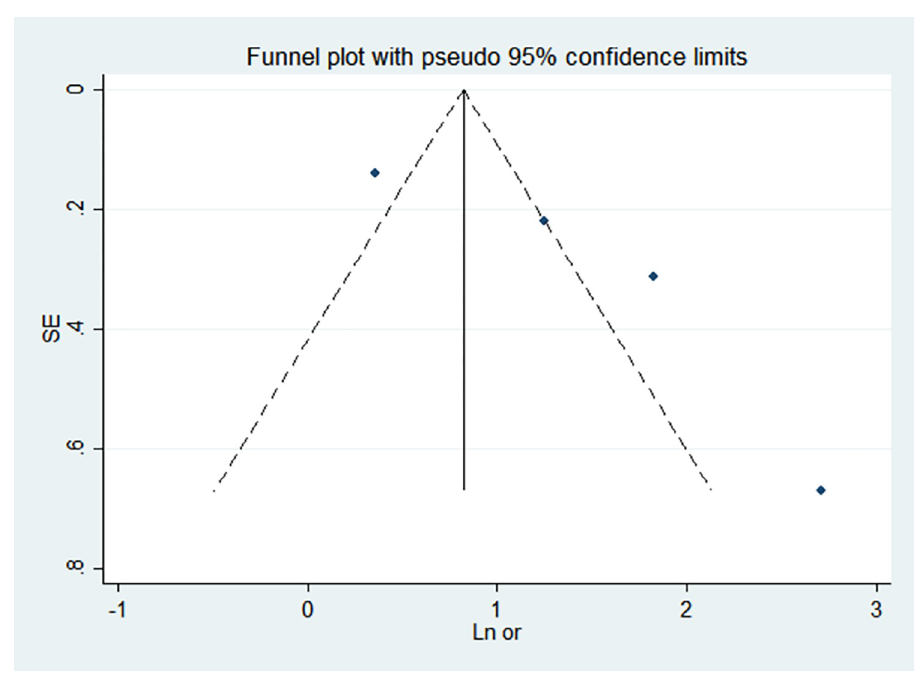
Fig 15. Funnel chart of parenteral nutrition